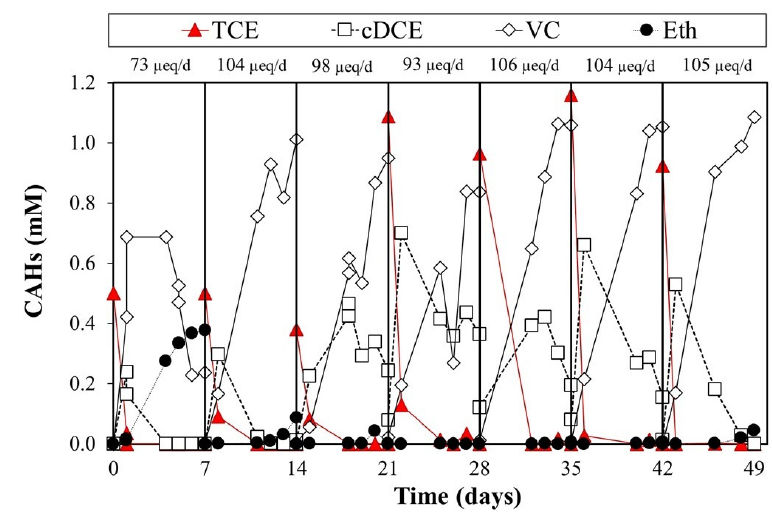
Figure 3. Lactate-fed reactor monitoring.